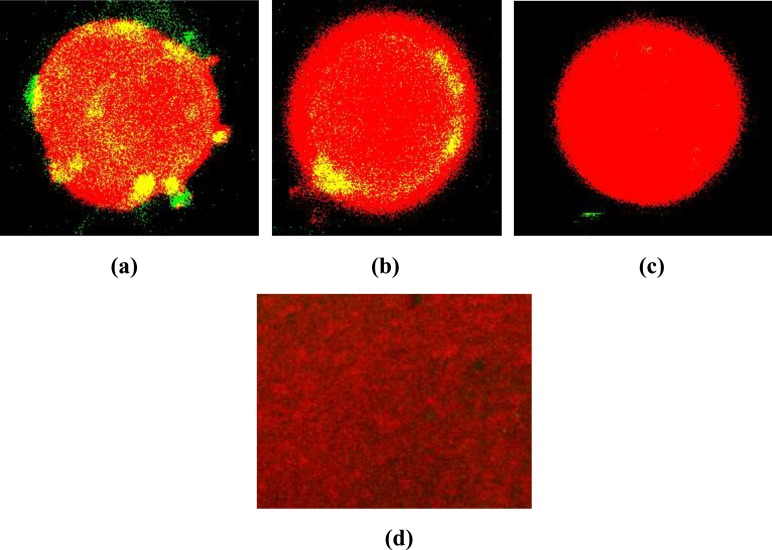
Visualization of a representative field of a) untreated macrophages having intracellular K. pneumoniae b) infected macrophages treated with bacteriophage at a MOI of 10 c) infected macrophages treated with liposome entrapped bacteriophage at a MOI of 10. d) control slide of heat killed bacteria stained with Live/Dead bacterial stain under confocal microscope (at 60X). The live bacteria were stained green and dead bacteria stained red.